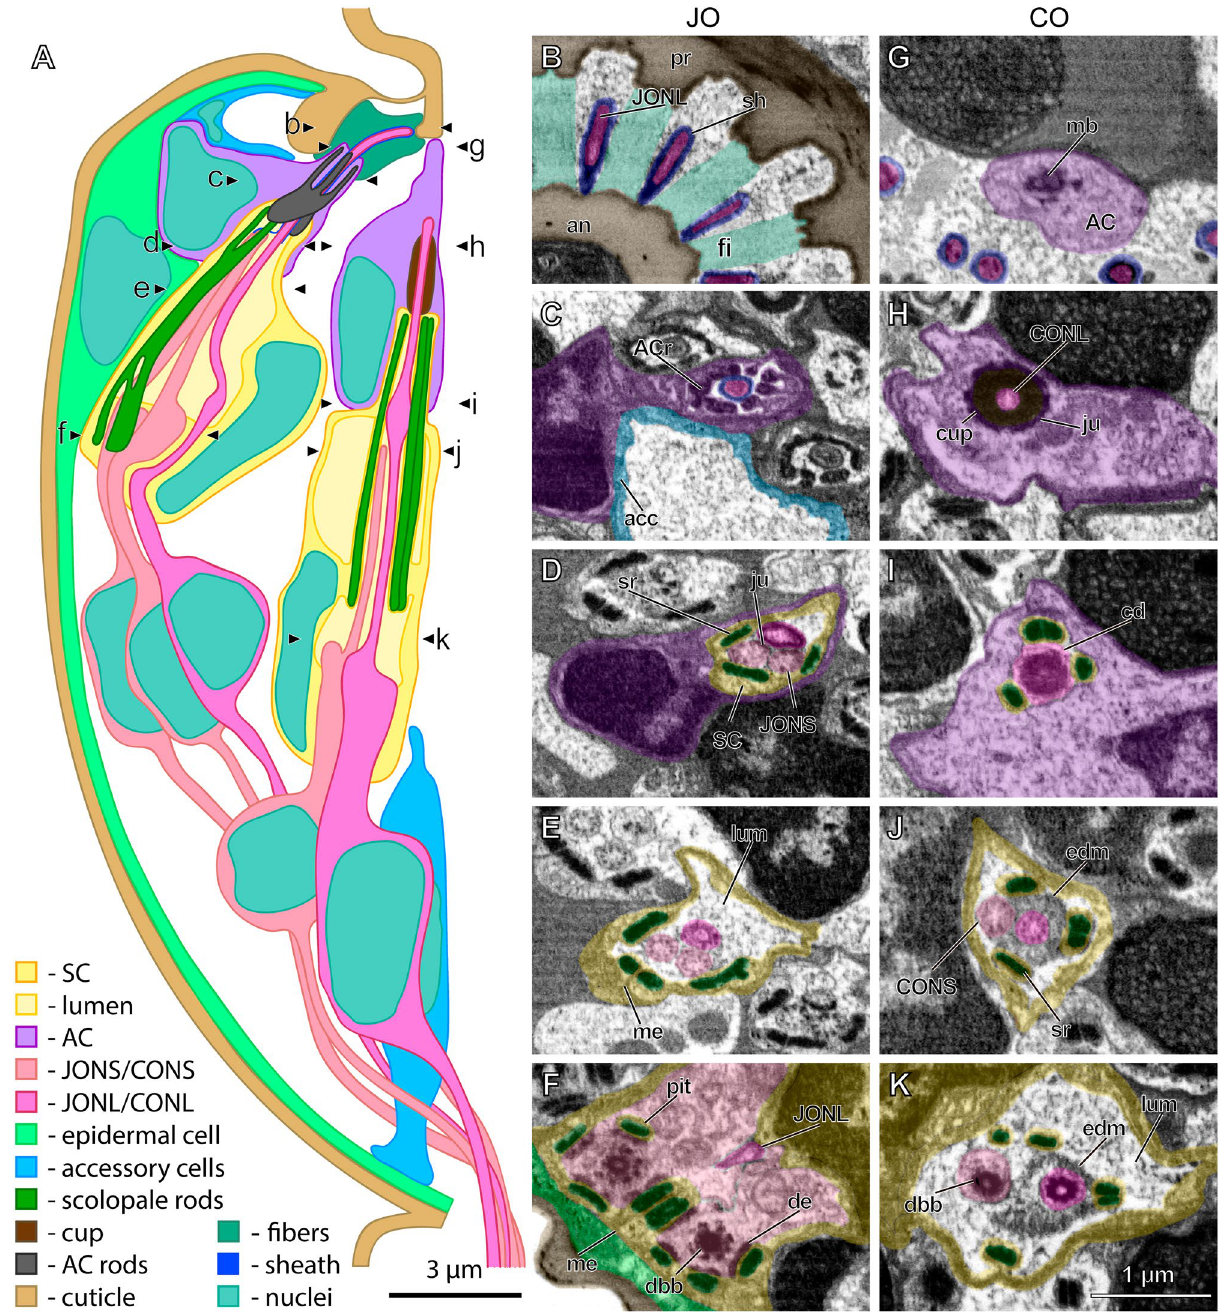
Figure 1. Ultrastructure of pedicellar chordotonal organs in Megaphragma viggianii . ( A ) Scheme of longitudinal section of M. viggianii pedicel with one Johnston’s organ (JO) and one central organ (CO) scolopidia. Letters designate the approximate location of cross sections shown in B–K. (B–F): Cross sections of JO scolopidium (FIB-SEM). ( B ) A sheath covers the tips of long JO neurons (JONL) cilia that lie between the fibers connecting pedicel rim and annelus. ( C ) Attachment cell (AC) forms a thin channel containing JONL cilium tip. Accessory cell surrounds a cavity filled with granular material. ( D ) Projections of scolopale cell (SC) containing scolopale rods surround JO cilia tips connected with junctions. ( E ) JO cilia lie in a lumen surrounded by SC that forms mesaxon. ( F ) Bulbs of short JO neurons (JONS) dendrites are joined by desmosomes to the scolopale rods, one rod is inserted in a small pit. ( G – K ): Cross sections of CO scolopidium (FIB-SEM). ( G ) A bundle of microtubules is observed in AC. ( H ) Tip of long CO neuron (CONL) cilium fits inside of a cap joined to the AC by junctions. ( I ) Four scolopale rods form a triangle around the cilium dilation of CONL. ( J ) A band of electron-dense material lies below the cilium dilation. ( K ) Distal basal bodies lie in CONL and short CO neuron (CONS) Cilia surrounded by electron-dense material. (acc—accessory cell, ACr—AC rods, an—annelus, cd—cilium dilation, dbb—distal basal body, de—desmosome, edm—electron-dense material, fi—fiber, ju— junction, lum—lumen, mb—microtubule bundle, me—mesaxon, pr—pedicel rim, sh—sheath, sr—scolopale